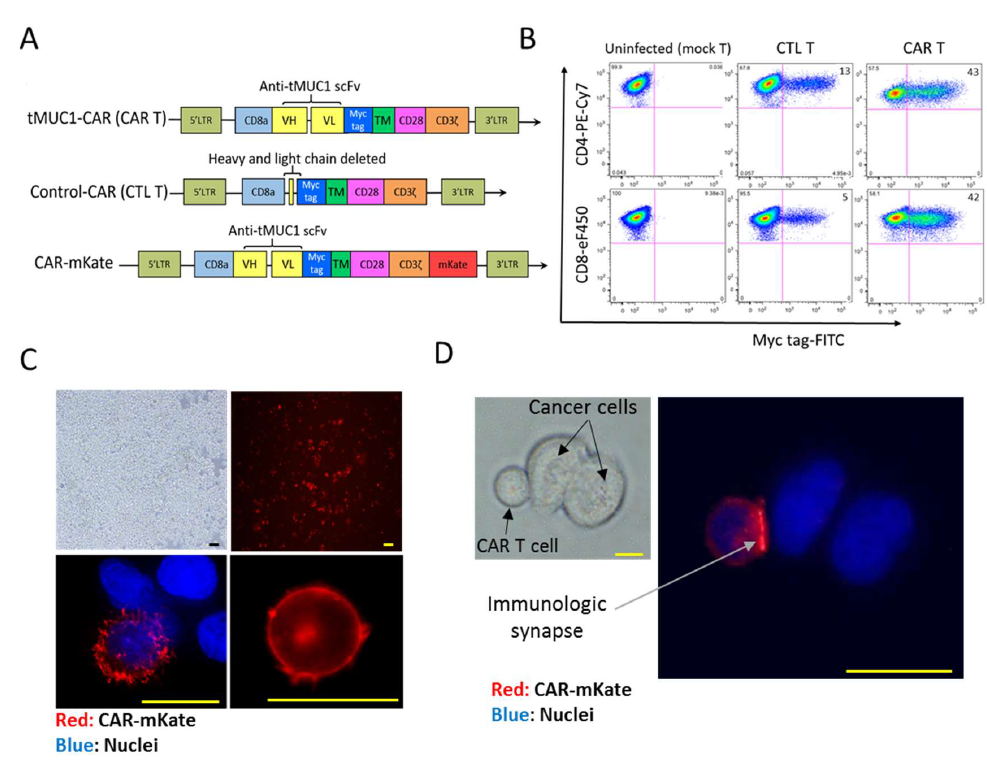
Figure 1. CAR architecture, expression on engineered T cells, and binding of CAR-T cells to target cells. ( A ). The architecture of three different CAR constructs used in this study. In the original construct (tMUC1-CAR), scFv of TAB004 Ab is linked to CD28 transmembrane (TM) domain followed by CD28 and CD3ζ intracellular domains in a retroviral plasmid. CD8a leader sequence was used as signal peptide for cell membrane expression of the CAR. In the CTL-CAR construct, scFv of TAB was removed. In the CAR-mKate construct, mKate2 gene was fused to the C-terminus of CAR flanking with a GA linker. ( B ). CTL-CAR and tMUC1-CAR expression measured by flow cytometry using FITC-conjugated anti-myc tag Ab, in CD4+ and CD8+ primary T cells on day 12 after infection. On average, 42% of T cells expressed tMUC1-CAR. ( C ). Bright field (top left) and fluorescent image (top right) of live T cells expressing CAR-mKate plated in 35 mm poly-D-lysine coated MatTek dish and imaged by DeltaVision workstation (Applied Precision, GE), projection image of a T cell expressing CAR-mKate (bottom left), and one Z image of the CAR-mKate T cell (bottom right) illustrating the ring-like structure around the cells formed by CAR-mkate expression, which indicates even distribution of CAR molecules on the T cell membrane. ( D ). Light and fluorescent image of CAR-mKate T cells binding to MUC1 expressing cancer cell (HPAFII). HPAFII cells were incubated with CAR-mKate T cells for 4 h, then T cells were removed, HPAFII cells were washed and imaged using DeltaVision microscope. The intense red signal observed between CAR T cell and HPAFII indicates co-localization and binding of CAR molecules, which suggests the formation of immunological synapse. Nuclei were stained with Hoechst nuclei blue dye in C and D. All scale bars = 15 um.